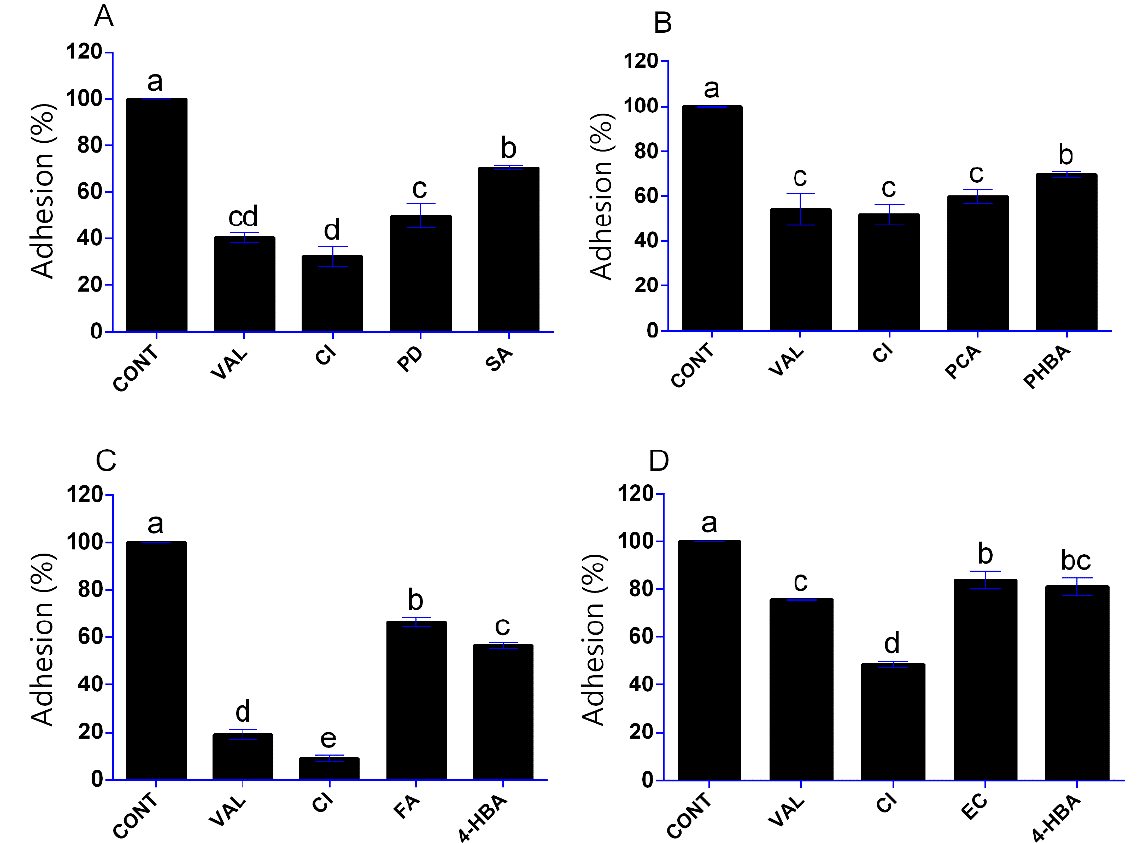
Figure 3. Effect of selected phenolic compounds (in 500 µ g/mL concentration) on the adhesion of D. hansenii SZMC 8045Mo ( A ), P. anomala SZMC 8061Mo ( B ), S. pombe SZMC 1280 ( C ) and S. cerevisiae SZMC 1279 ( D ) yeasts to polystyrene surface. Phenolic compounds: vanillin, VAL; cinnamic acid, CI; polydatin, PD; syringic acid, SA; p -coumaric acid, PCA; 4-hydroxybenzoic acid, PHBA; ferulic acid, FA; 4-hydroxybenzaldehyde, 4-HBA; (-)-epicatechin, EC. Adhesion of cells in the absence of phenolic compounds was taken as 100% (CONT). Results are presented as mean of replicates; error bars represent standard deviation. The different letters above the columns indicate significant differences according to one-way ANOVA followed by Tukey’s multiple comparison test ( p < 0.05).